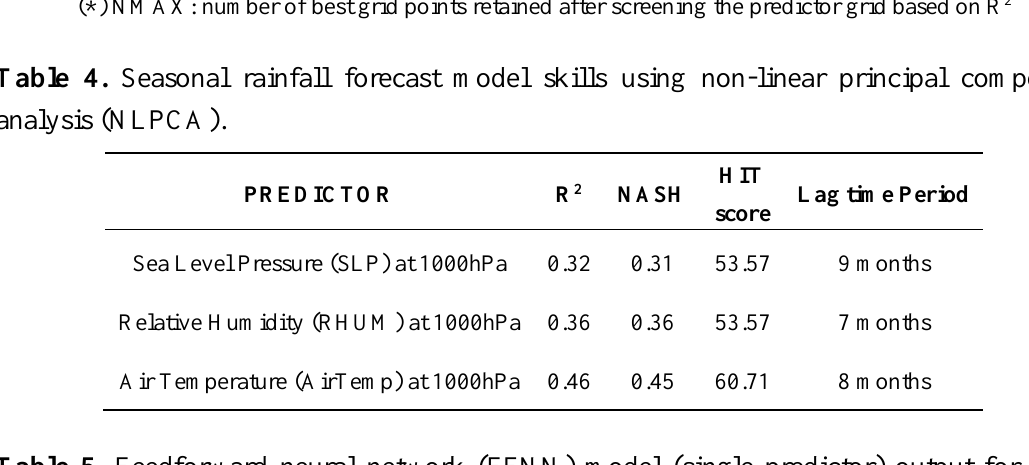
Table 5. Feedforward neural network (FFNN) model (single predictor) output for Sirba seasonal rainfall